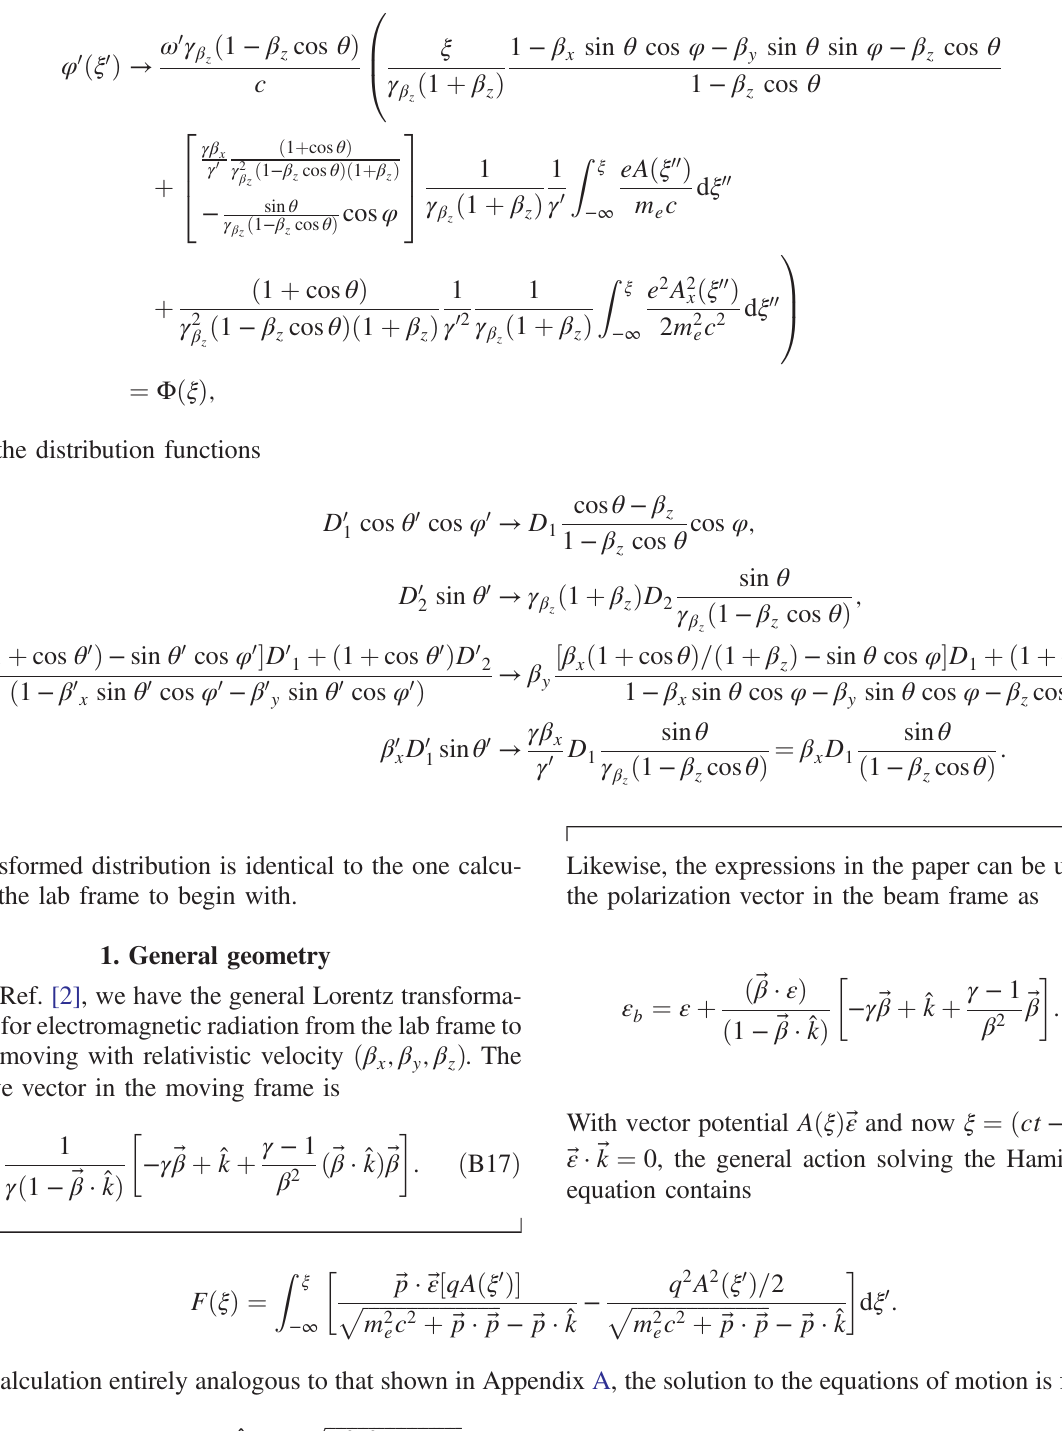
p c 2 þ ⃗ p · ⃗ p m 2 e